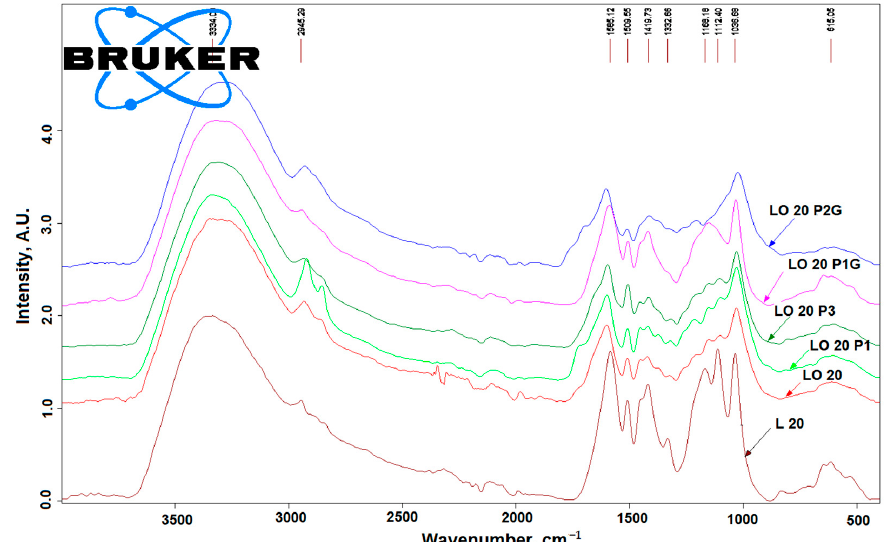
Figure 2. FTIR analysis for oxidized LIGNEX MG F and cross-linked adhesives with PMDI and glucose.